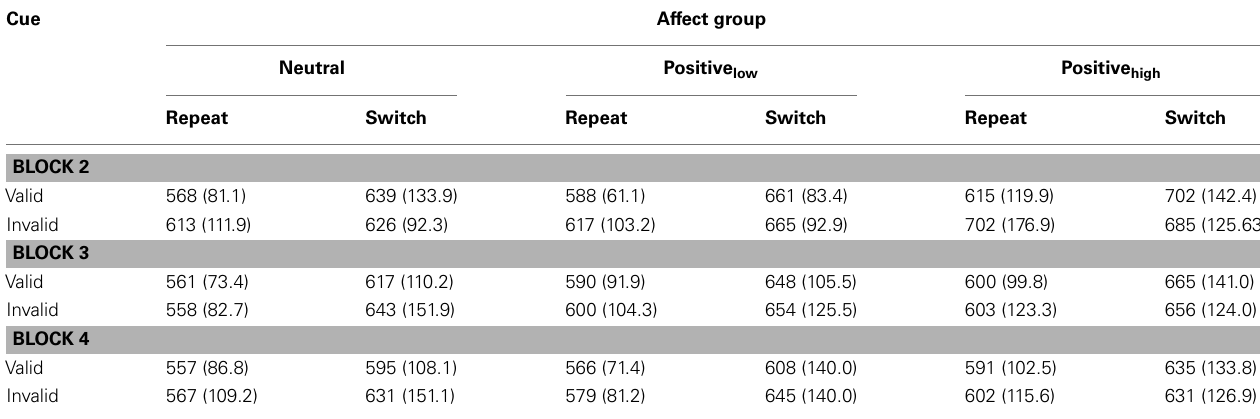
Table 4 | Mean RTs (in ms, SD in parentheses) in experimental blocks 2–4 of Experiment 3 (task switching with informative task cues) as a function ofAffect group,Trial type, and Cue validity.